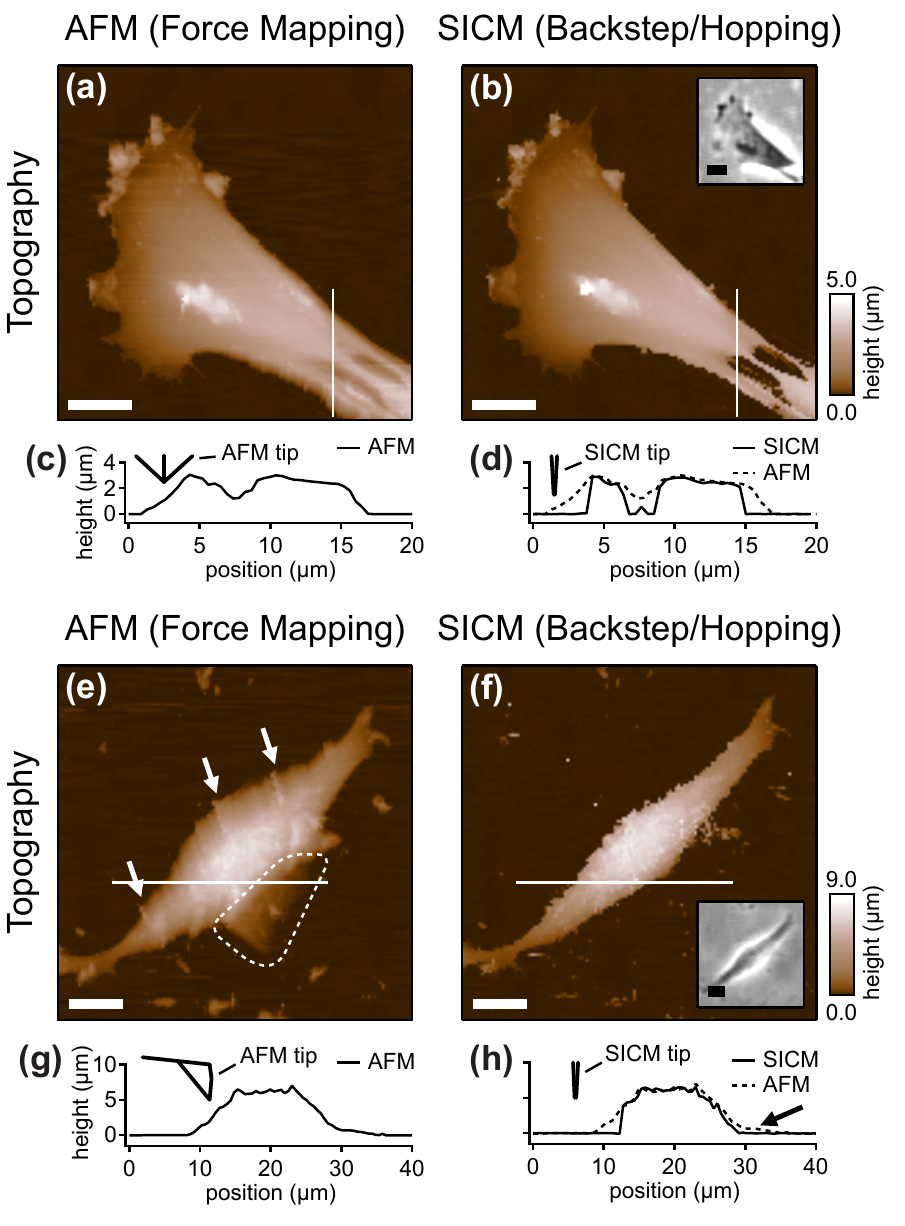
Figure 8. AFM force mapping ( a , e ) and backstep (hopping/STA) SICM ( b , f ) images of the two samples. The profiles along the lines in the respective scans are shown in ( c ), ( d ), ( g ) and ( h ). Note that at steep sample regions the AFM images appear broader than the SICM images. Furthermore, due to interactions between the basal part of the AFM tip and the sample, artificial tail-like structures are observed (dashed region in ( e )). Reprinted with permission from [38]. Copyright 2011 American Chemical